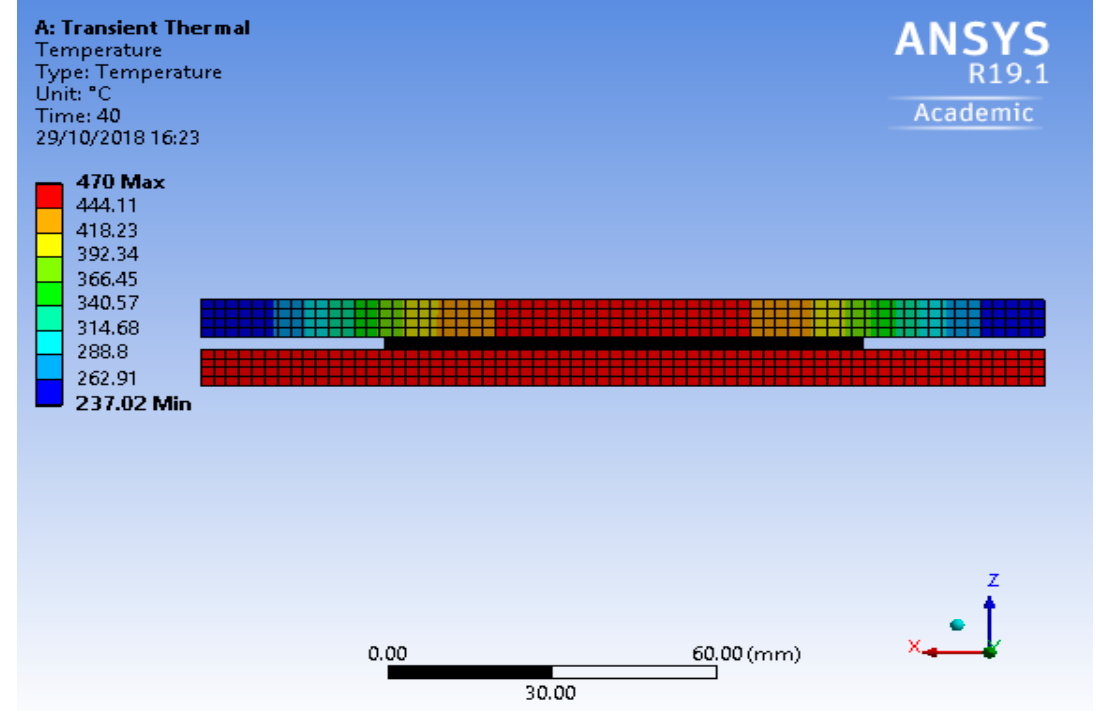
Figure 4. Temperature distribution on the plates and the dog bone specimens.